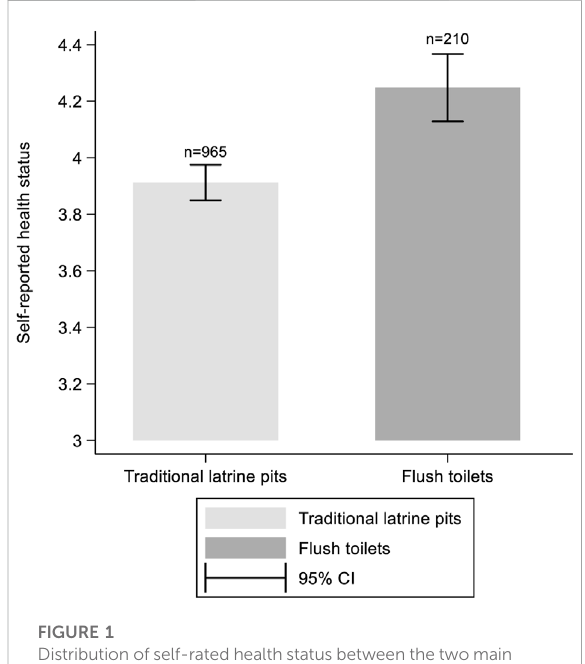
FIGURE 1 Distribution of self-rated health status between the two main